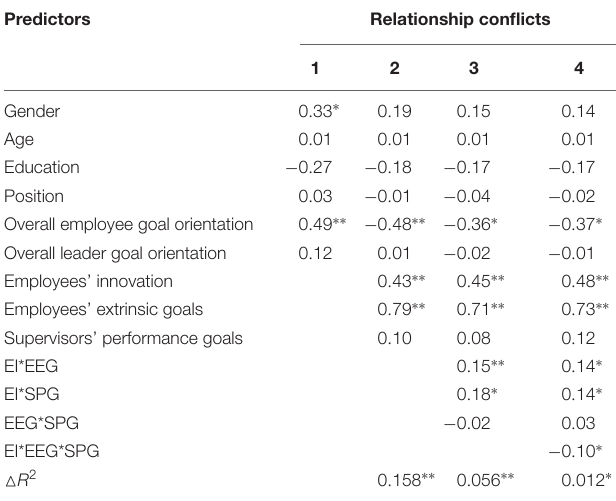
TABLE 3 | Results of multilevel analyses testing hypotheses.